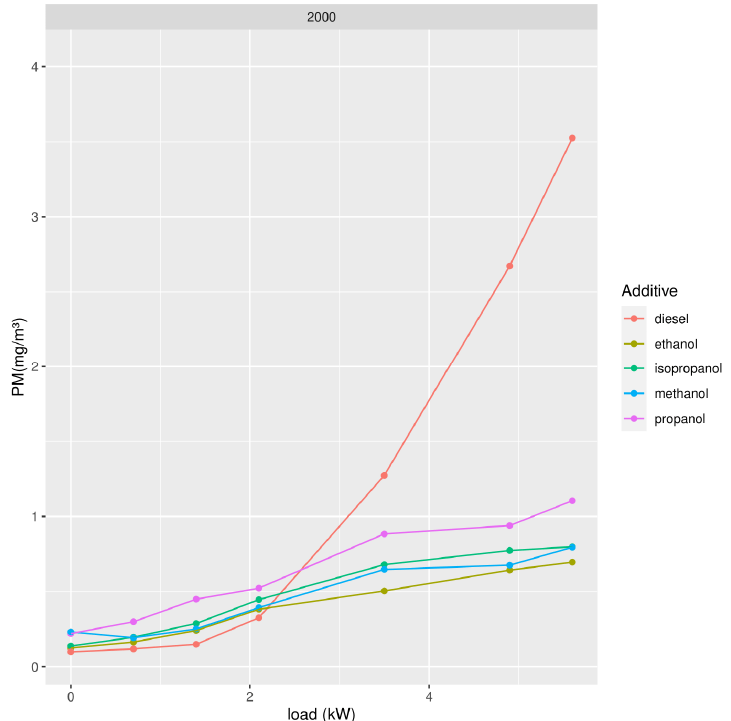
Figure 7. Concentration of PM in exhaust gases in function of the power of the diesel generator after addition of 2000 ppm of methanol, ethanol, propanol, and isopropanol.